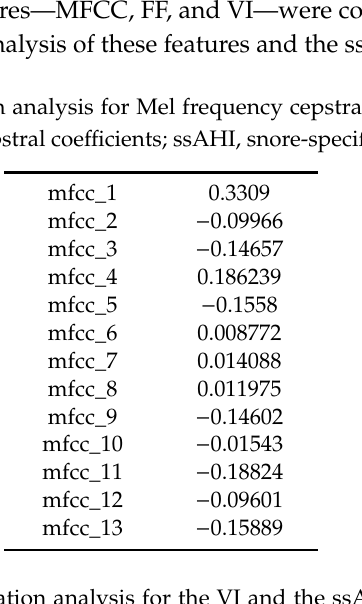
Table 5. The results of the correlation analysis for the VI and the ssAHI. (VI, volume information; ssAHI, snore-specific AHI).